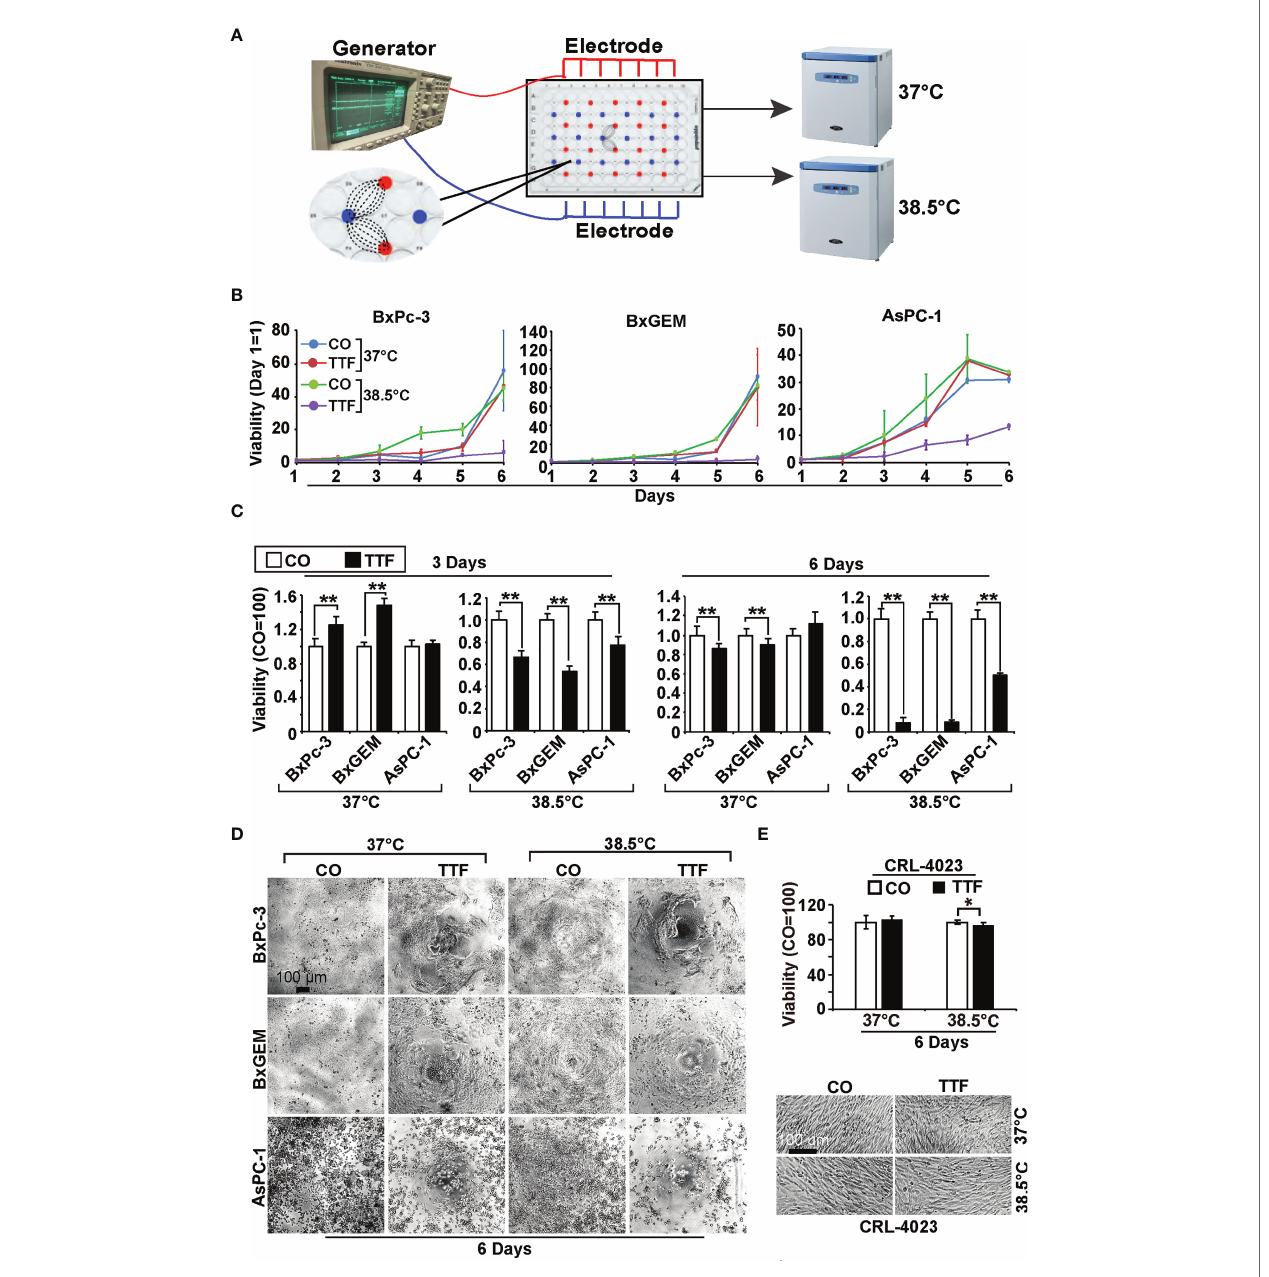
FIGURE 1 | TTField-mediated inhibition of viability is enhanced by hyperthermia. (A) The scheme illustrates the treatment of PDAC cells with TTFields at a regular incubation temperature of 37°C or mild hyperthermia at 38.5°C. (B) The human PDAC cell lines AsPC-1, BxPC-3 and BxGEM were incubated at 37°C or 38.5°C in the presence (TTF) or absence (CO) of TTFields at 150 kHz and an intensity of less than 0.7 V/cm. To measure TTField effects as a function of treatment duration, PDAC cells were treated for 1 to 6 days in separate experiments. The examination of all 6 days together in one large experiment was not possible because the availability of the cell culture plates with antenna wires was limited. At the end of each single experiment, the viability was measured by MTT assay, the results were accumulated as a total curve for each cell line, and the values of each curve were normalized to start at 0 on day 1. (C) The cells were treated as described above, and the viability was analyzed 3 or 6 days later by MTT assay. The controls were set to 1. (D) The morphology of the cells, which were treated as described above, was microscopically examined at 100× magni fi cation 6 days after treatment, and representative images are shown. The scale bar indicates 100 µm. (E) Likewise, the viability of the human, nonmalignant pancreatic duct cell line CRL-4023 was evaluated by MTT assay and microscopic evaluation at 100× magni fi cation. Representative images of each treatment group of CRL-4023 cells 6 days after treatment are shown. Three independent experiments were performed at least in triplicate, and the data are presented as the means ± SD; *P < 0.05, **P <